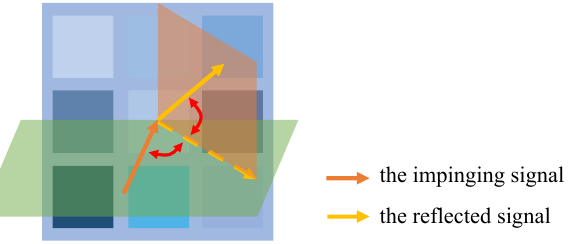
Figure 4. A sketch map illustrating an RIS manipulating reflection angles in two